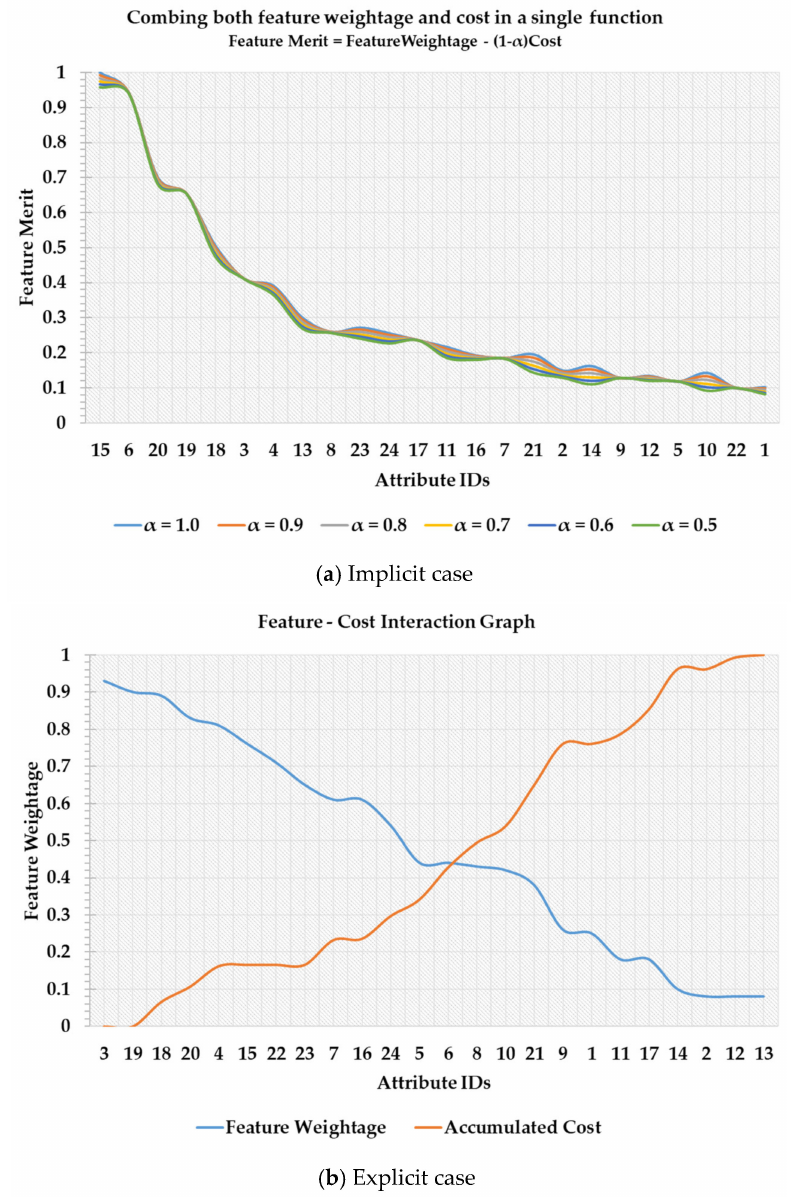
Figure 1. Cost-sensitive feature ranking and threshold selection.